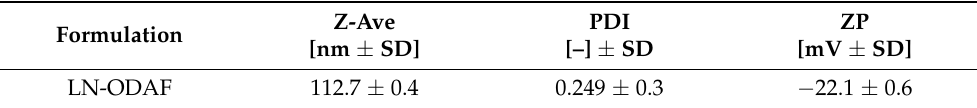
Table 1. Mean particle size (Z-Ave), polydispersity index (PDI) and zeta potential (ZP) of LN-ODAF.